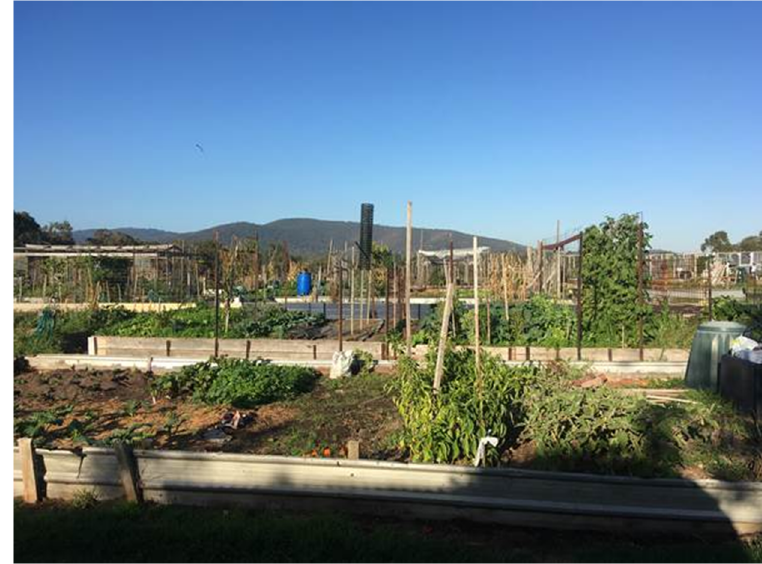
Figure 2. Knox Garden, Boronia, Victoria.